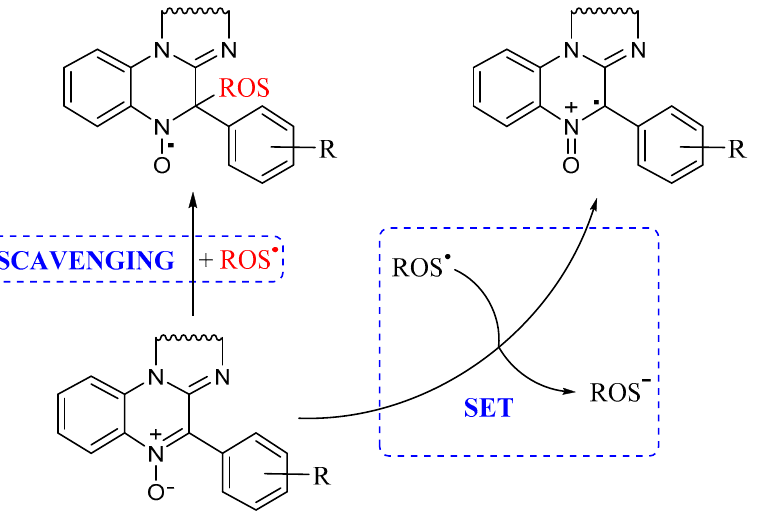
Figure 3. A possible mechanism for nitrone antioxidant activity. Such behavior depends on the redox potential of the species involved; concerning the nitrones under investigation, their tendency to undergo oxidation should be lowered by the presence of electron-withdrawing groups. This seems to be in line with our findings, indicating that derivatives 2, 3, 5 and 10 are identified as being less active as antioxidants. In order to have additional indications concerning this possibility, the ionization potentials of all studied nitrones have been computed by means of proper DFT